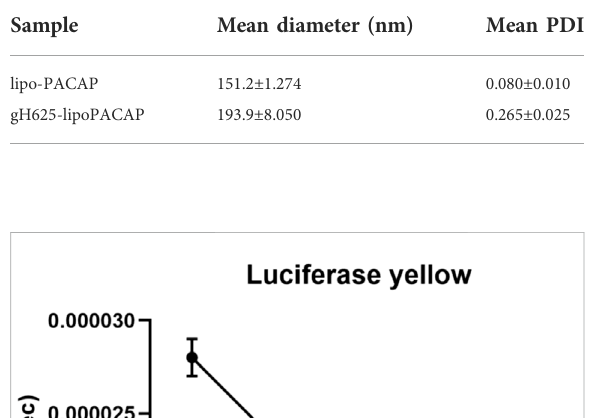
TABLE 1 Results of the polydispersity index (PDI) for lipo-PACAP and gH625-lipoPACAP is < 0.3. This represents a good size distribution.